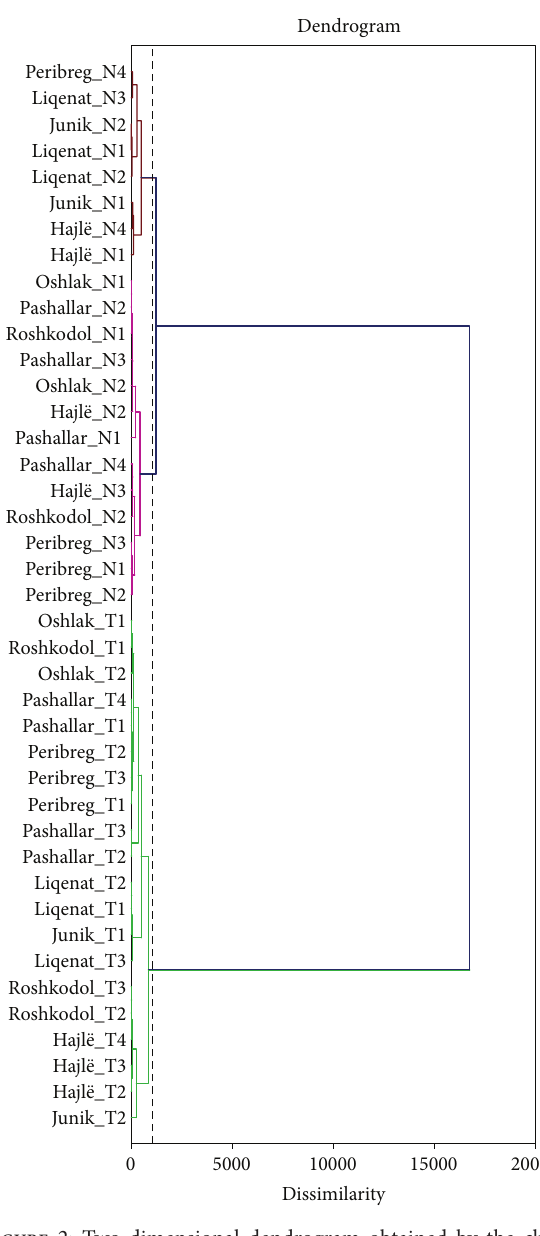
Figure 2: Two-dimensional dendrogram obtained by the cluster analysis of the essential oils of seven populations of Pinus peuce based on the unweighed pair group method (square Euclidean distance). N: needles and T: